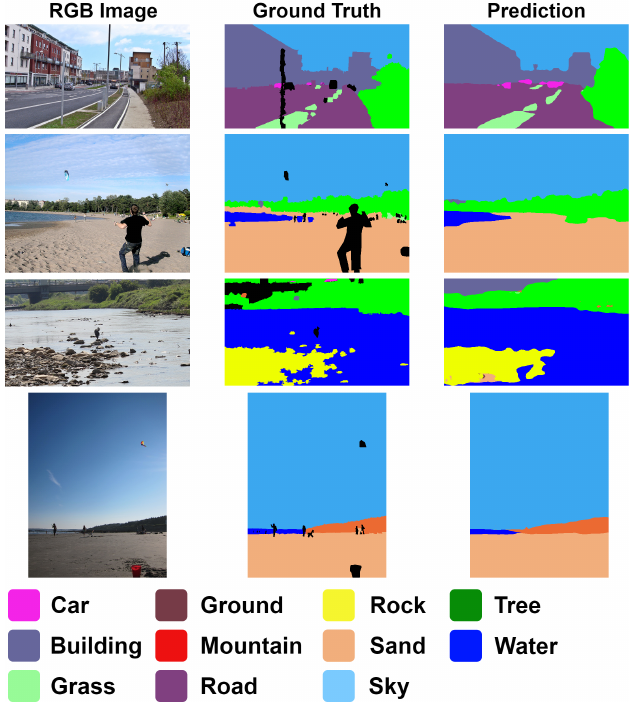
Figure 4. Predictions made on the custom version of COCO-Stuff (11 classes). The black pixels in the ground truth images contain classes that were not considered during